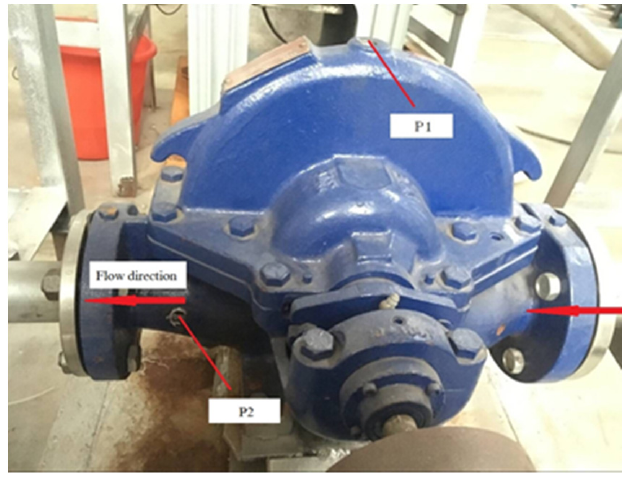
Figure 1. Test pump and the monitoring points distribution.